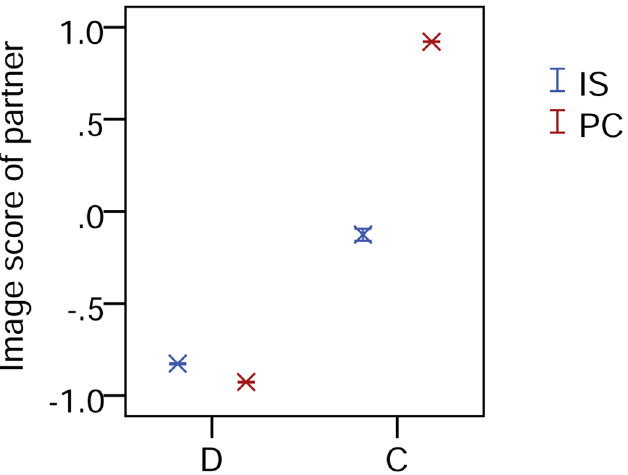
Fig 4. Discrimination in image scoring and partner choice. Discrimination between recipients as shown by the image scores of those with whom focal individuals cooperated (C) or defected (D), plotted as means ± SEM for pure image scoring with random assignment (IS) and partner choice